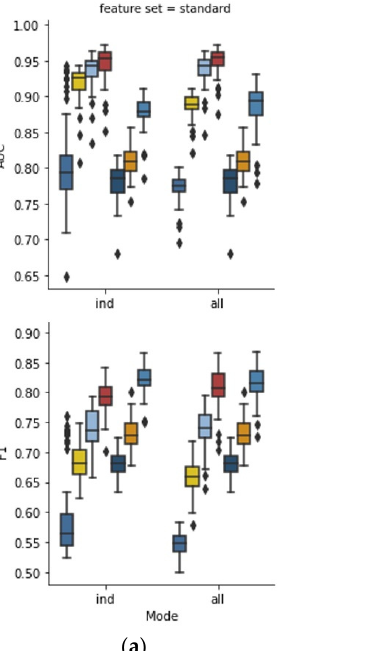
approaches, except for LogR and mode ‘individual’ as well as KNN and mode ‘all’. As